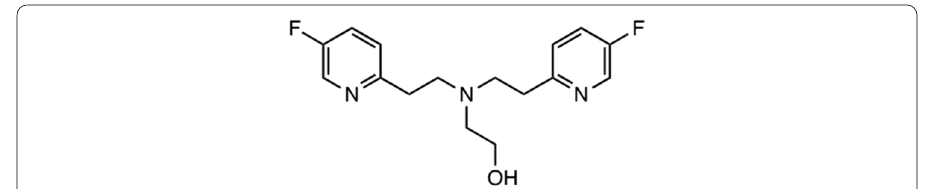
Fig. 4 Chemical structure of fluorinated chelate with fluorine substituents in the pyridine